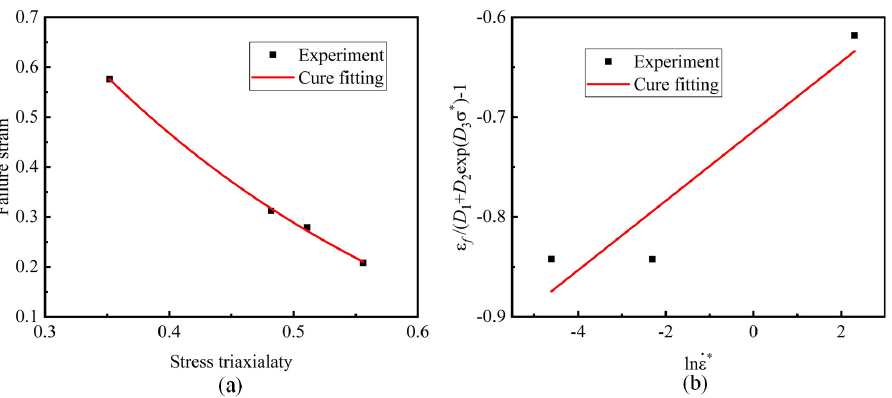
Figure 9. Johnson–Cook fracture model fitting curves: ( a ) fitting parameters D 1 – D 3 ; ( b ) fitting parameter D 4 .